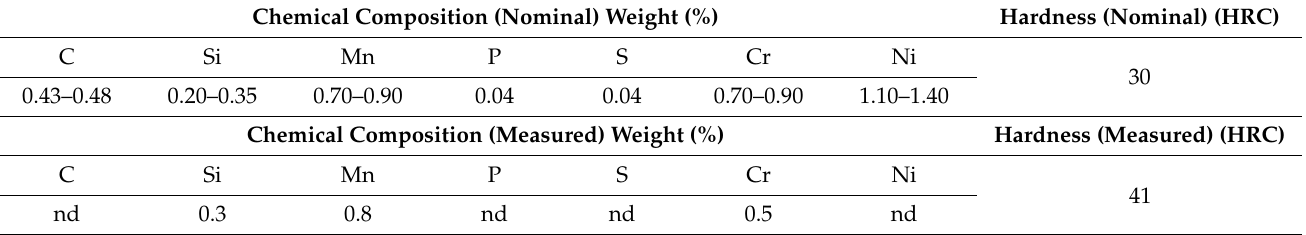
Table 3. Comparison of the chemical composition and hardness analysis of the original material with the H13 tool